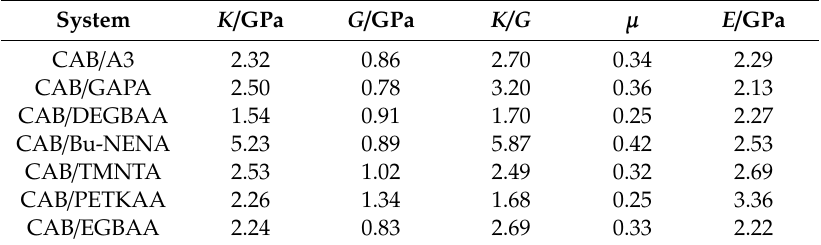
Table 3. The mechanical parameters of CAB /